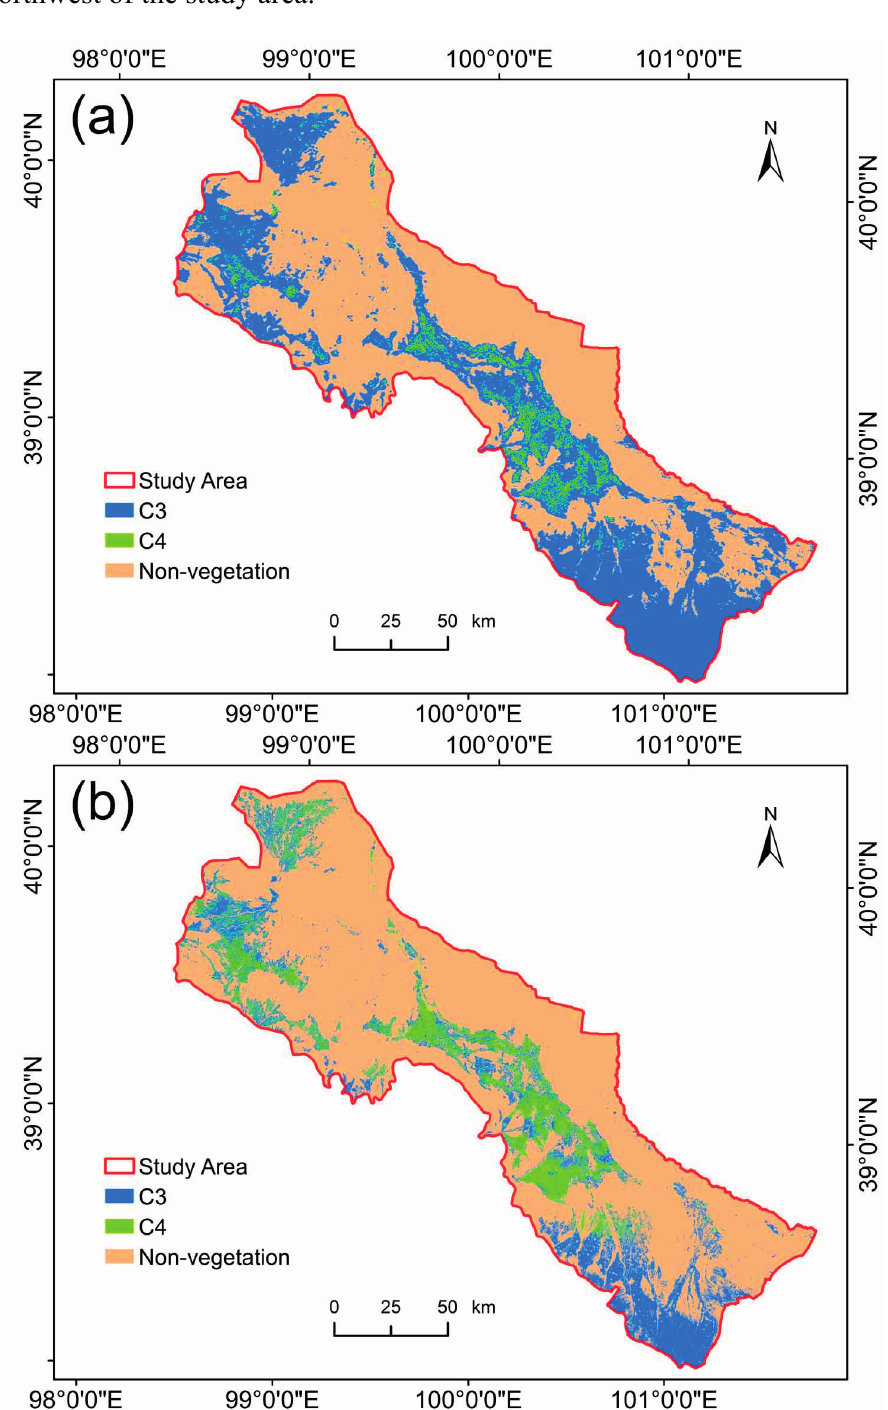
Figure 14. The C3 and C4 vegetation classification results over the study area. ( a ) the C3 and C4 vegetation classification result of MODIS data; ( b ) the C3 and C4 vegetation classification result of MODIS and ETM+ blended